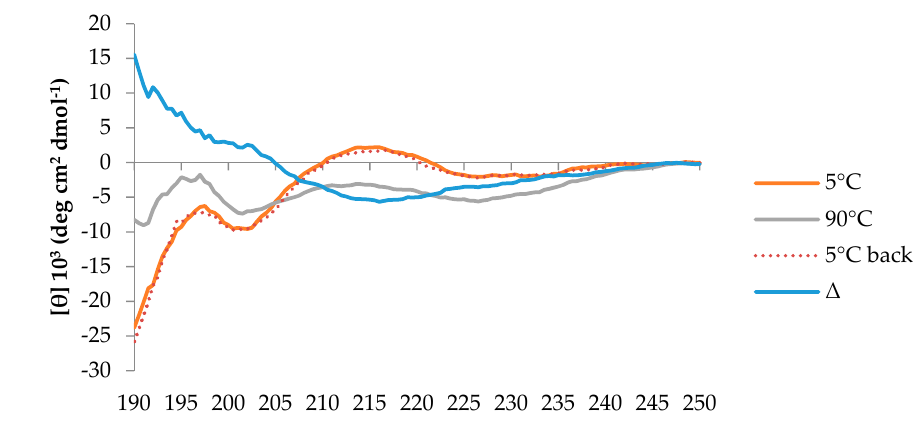
Figure 1. Far-UV CD spectra of 70 μ M T11F (TCRVDHRGLTF) obtained immediately after preparation of the starting aqueous solution. ( a ) Spectra acquired starting from 5 °C up to 90 °C; ( b ) T11F thermal denaturation and renaturation. Spectra obtained at 5 °C, after heating at 90 °C, and back to 5 °C. Δ : difference spectrum between 5 °C and 90 °C.